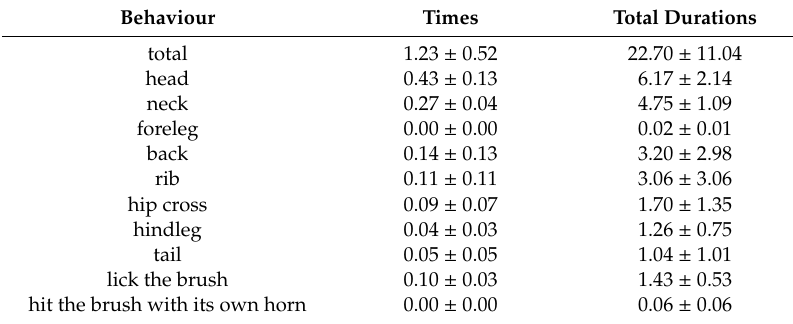
Table 4. Mean times (per hour ± SEM) and total durations (seconds per hour ± SEM) of the total amount of brush use and scratching each cattle’s body region on the brush in Trial